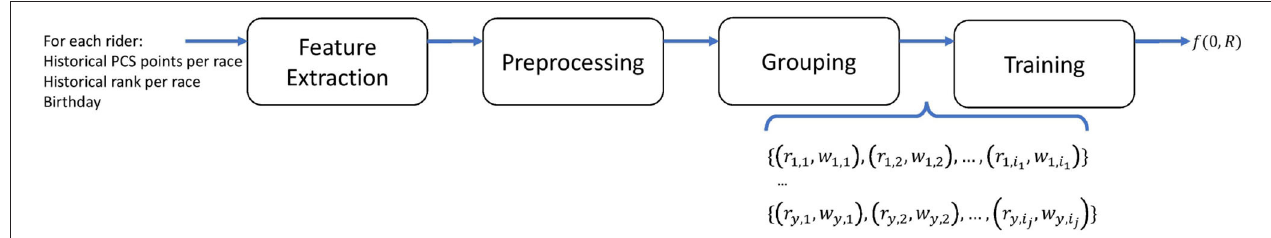
FIGURE 2 | Pipeline for training a Learn-to-Rank model for 1-day road cycling races. The grouping stage outputs y subsets corresponding to the number of years used to train the model. Each subset contains pairs of riders r and an associated weight w . Each subset can contain a different number of